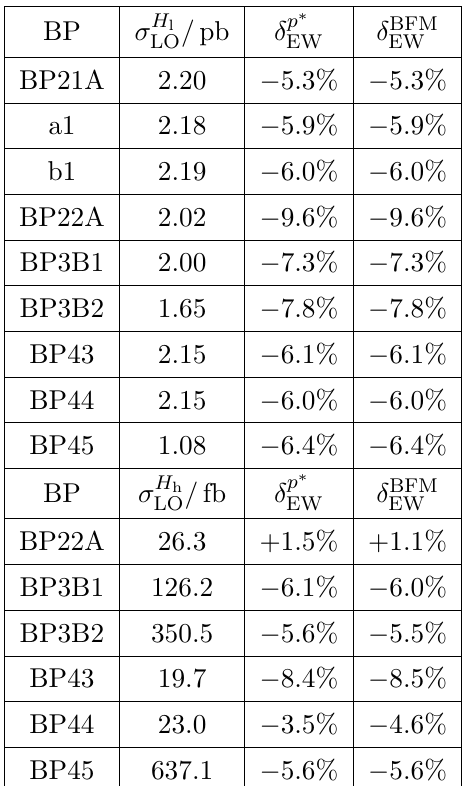
Table 13. Relative NLO corrections (cid:14) 2HDM. The SM-like Higgs production is in the upper table, indicated as (cid:27) H l one is the lower table, indicated as (cid:27) H h